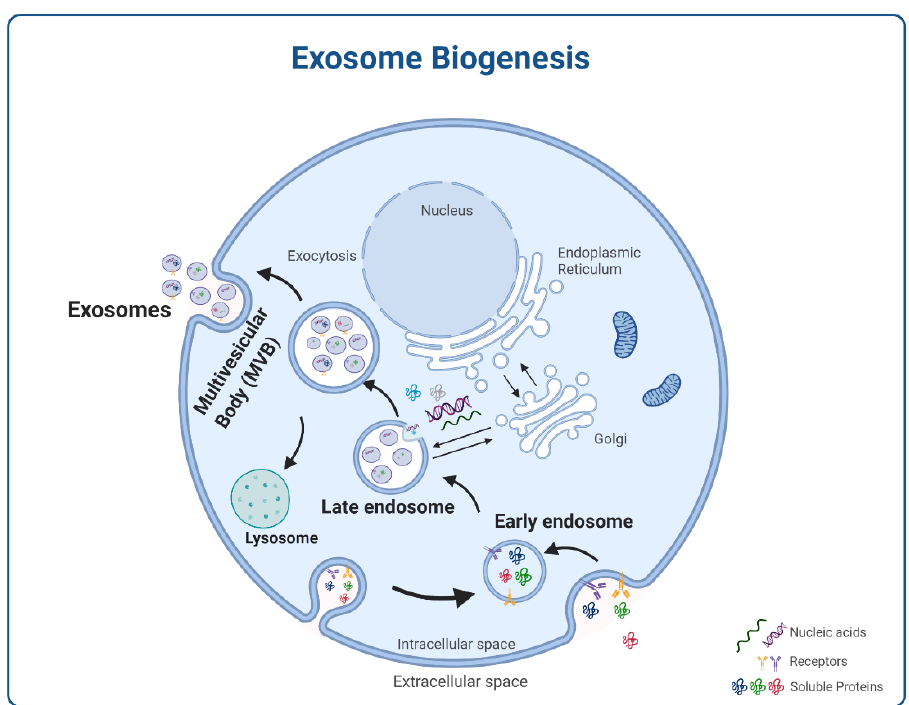
Figure 2. Exosome biogenesis comprises three sequential steps, starting from the invagination of the plasma membrane to form endocytic vesicles (that fuse to form early endosomes) in the intracellular space, followed by their maturation and additional cargo incorporation (nucleic acids, receptors, soluble proteins, etc.) giving rise to multivesicular bodies (MVBs). Lastly, these MVBs could either fuse with lysosomes for degradation or move to merge with the plasma membrane and release their vesicular content, the exosomes, to the extracellular space. Created with